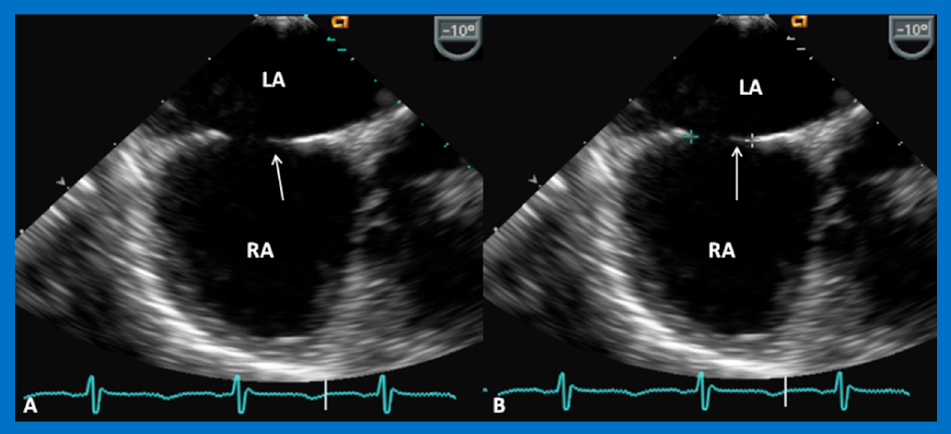
Figure 25. Transesophageal echo of the atrial septal defect, demonstrating the thin margin (arrow) of the atrial septal defect ( A ) which is not included ( B ) in the measurement of the size of the defect. LA, left atrium; RA, right atrium. Reproduced from Reference [6].